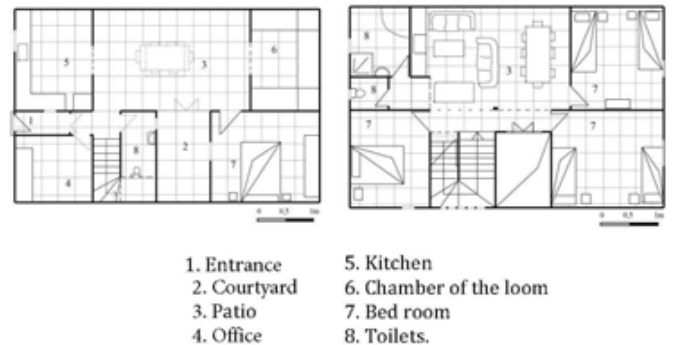
Figure 6. Theplans adopted for the Tafilelt village in the M’Zab valley (Bouali-Messahel,2011).